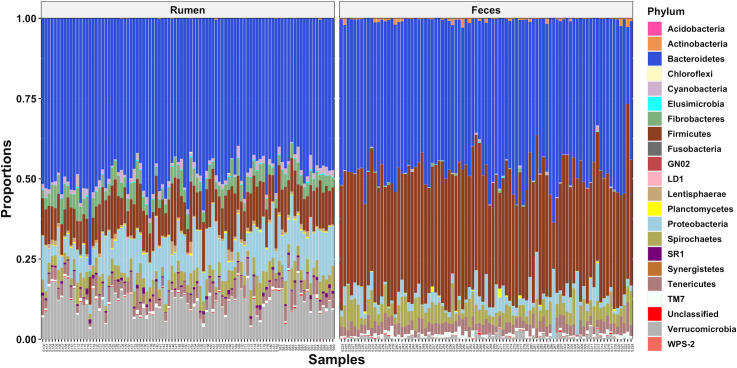
Phyla level classification of the bacterial communities from the rumen and feces of dairy cows.